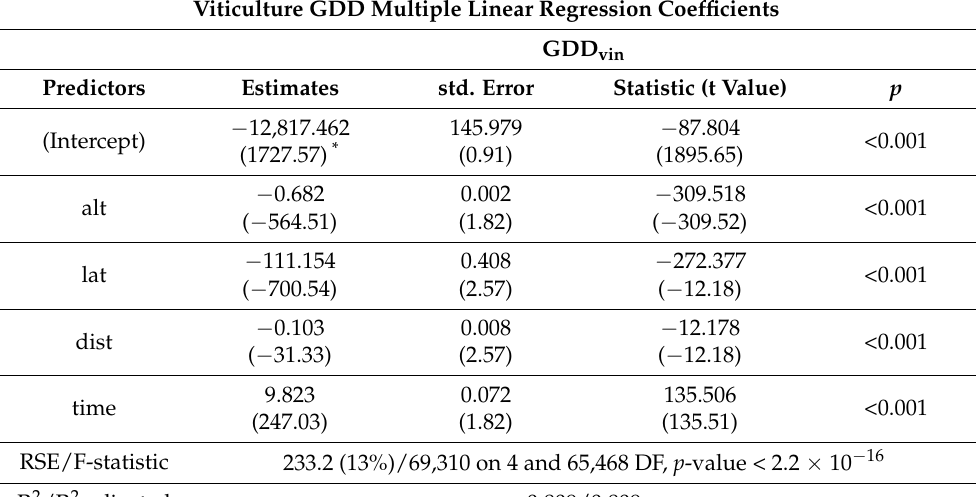
Table 4. Multiple linear regression model coefficients for the GDD units of the viticulture.